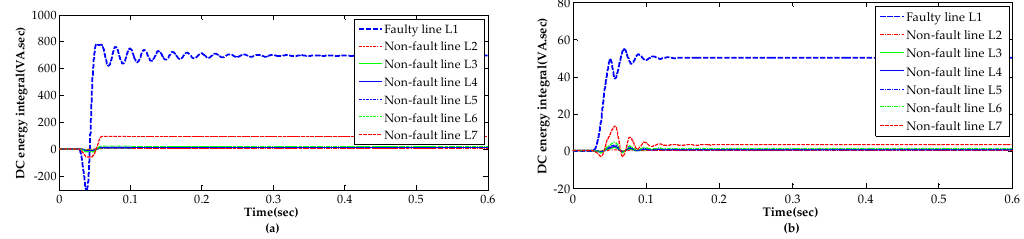
Figure 10. Results under SPG faults occurring on the shorter line L 1 at 2 km away from the bus, at different initial phase angles and resistances. ( a )